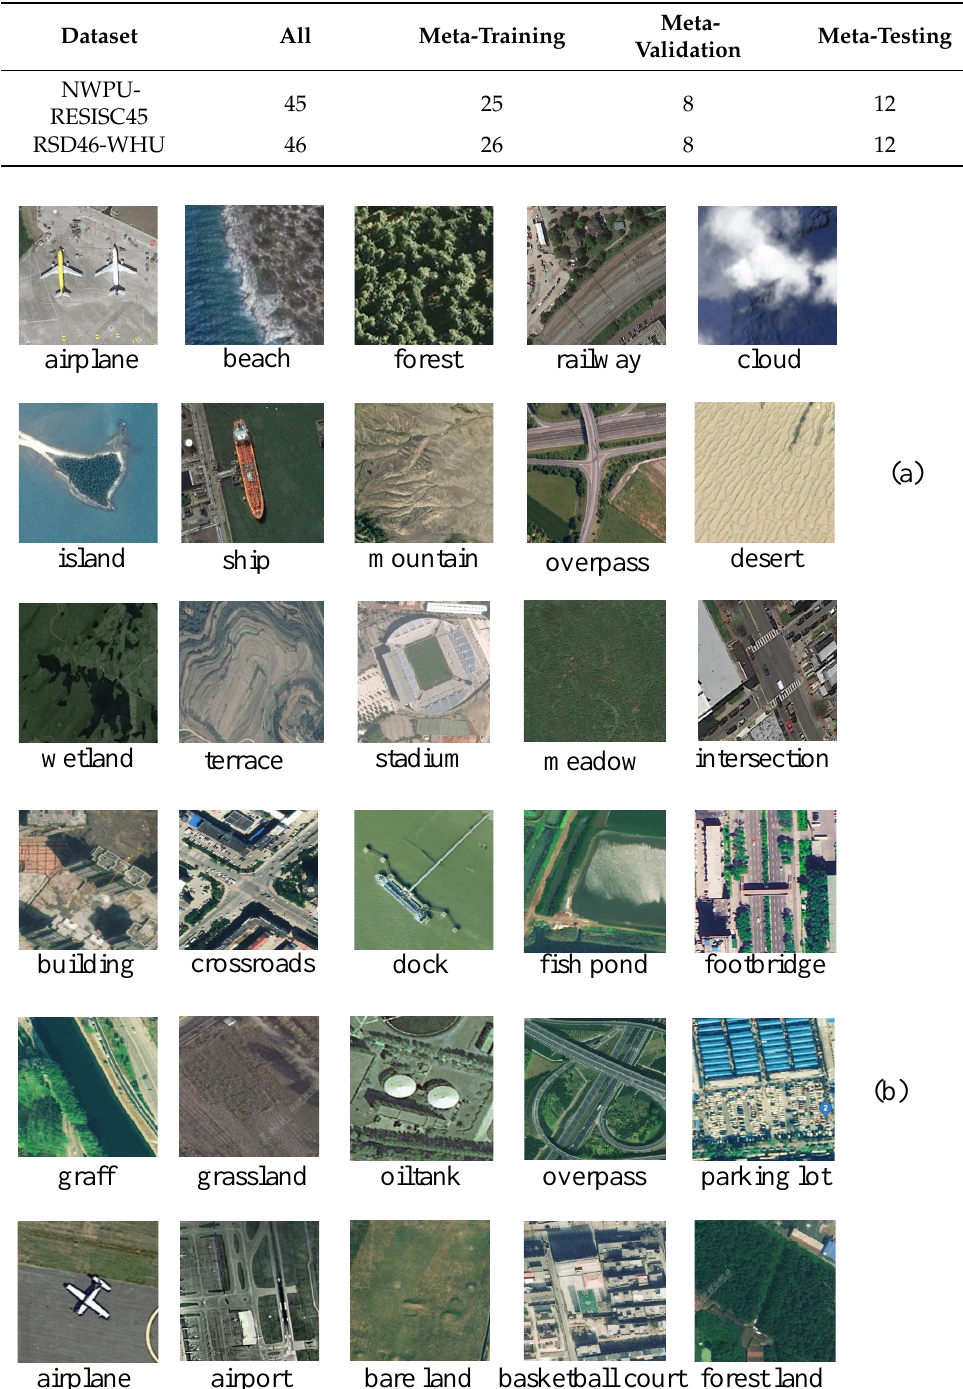
Table 1. NWPU-RESISC45 and RSD46-WHU dataset category information.